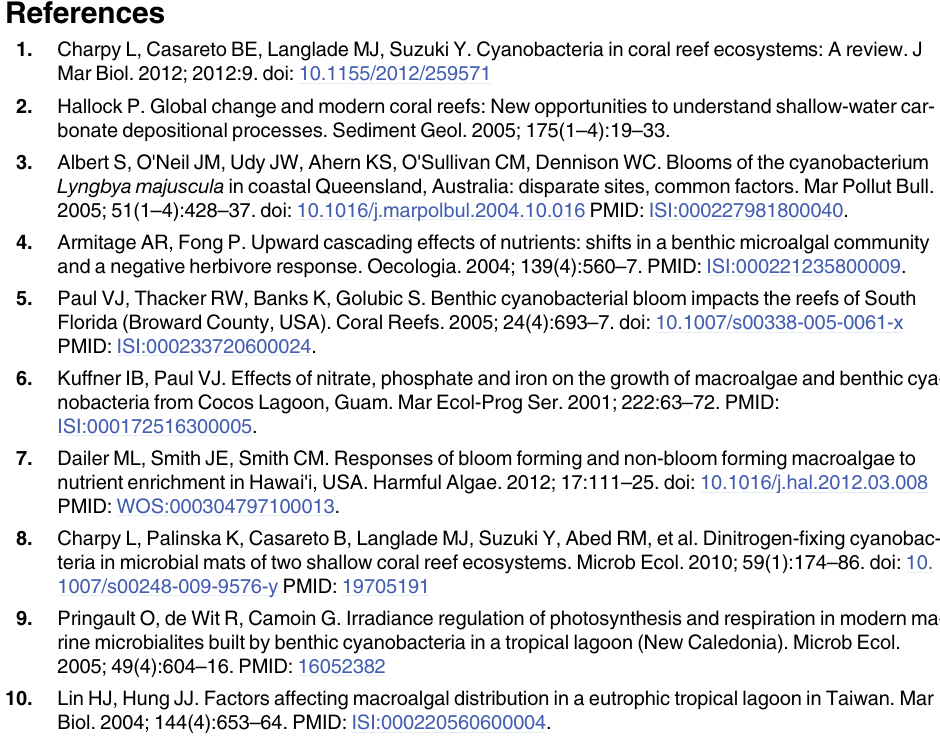
S4 Table. Statistical output table for particulate organic matter concentrations in the water column. PERMANOVA results of the effects of BCM site abundance (fixed) and site nested within BCM site abundance (random) on concentration of particulate organic matter in the water